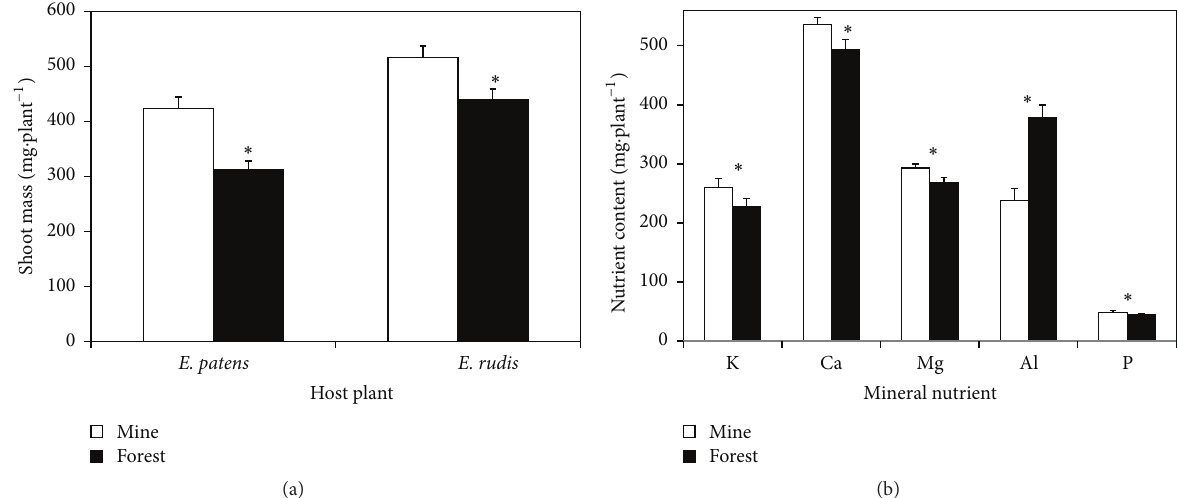
Figure 3: Effect of inoculation with mine or forest site Pisolithus ecotype on shoot biomass (a) and foliar levels of K, Ca, Mg, Al, and P (b) in Eucalyptus plants in the field trial. Vertical bars indicate the standard error of the mean. For each plant species (a) or nutrient (b), mean values indicated with an asterisk ( ∗ ) differ significantly at 𝑝 < 0.05 ; ns: not significantly different ( 𝑝 > 0.05